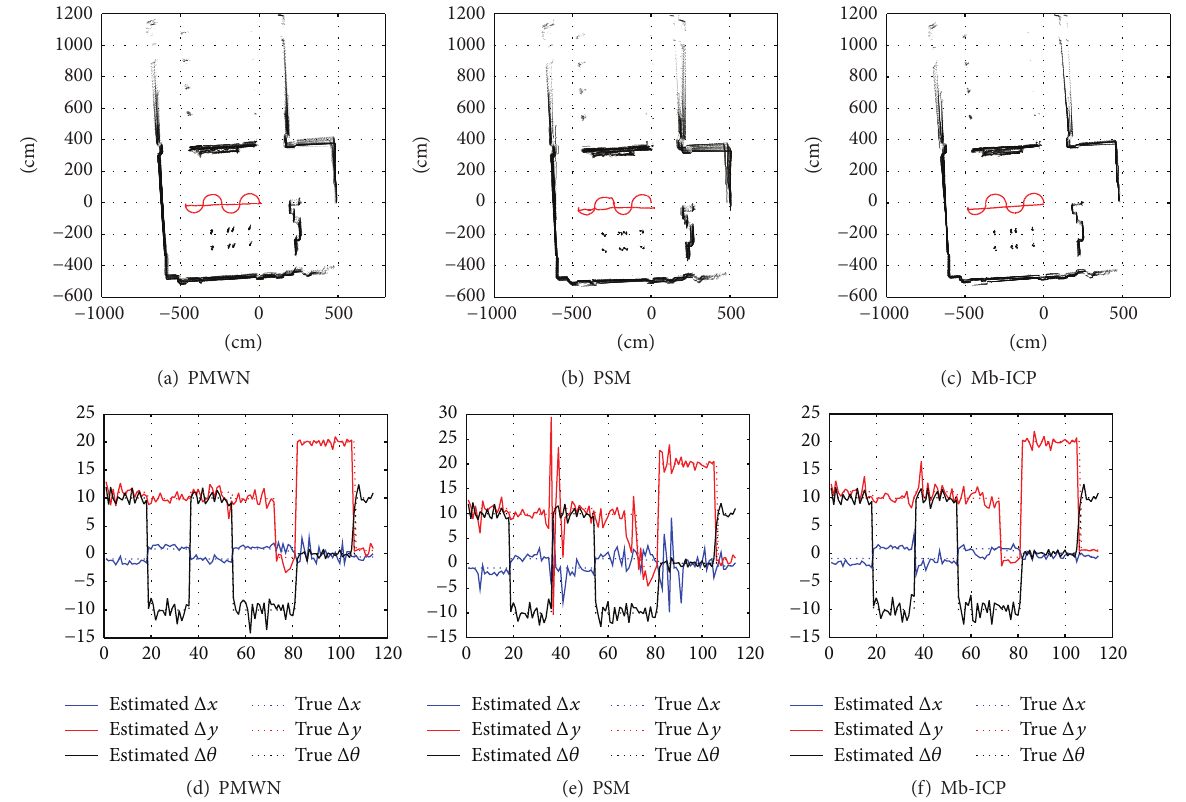
Figure 16: Experiment in hall using Series 1 path. ((a), (b), and (c)) The laser sensor is continually placed on footprints of Serial 1 path using PMWN, PSM, and Mb-ICP, respectively, to map the hall. ((d), (e), and (f)) Compare the pose estimation of PMWN, PSM, and Mb-ICP, respectively, with the true pose of Series 1 path in the